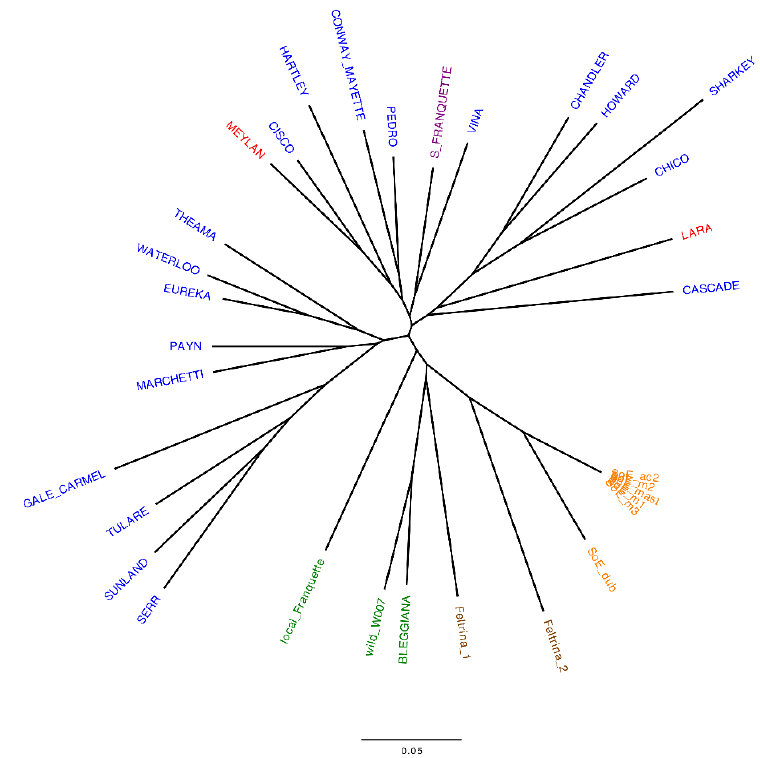
Figure 2. Unrooted neighbor-joining tree produced from Prevosti’s distance matrix estimated from SNP data. Labels are colored according to the geographical origin: green = northeastern Italy—Trentino; brown = northeastern Italy—Veneto; orange = south Italy—Campania; red = France; blue = USA; violet = France/USA.